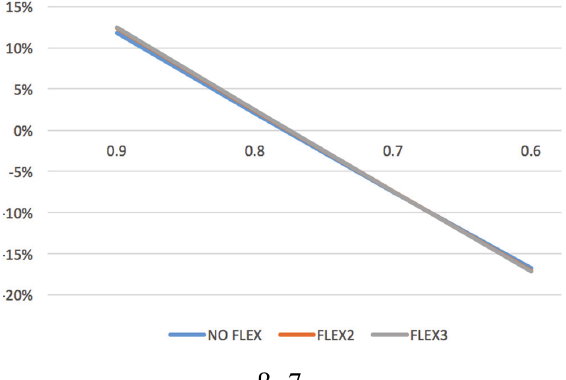
Same results for other  values.